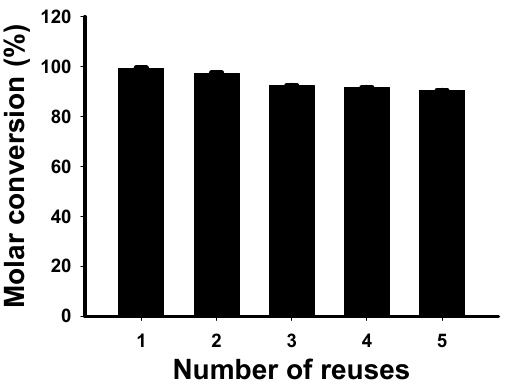
Figure 6. Reusability of Novozym ® 435 in the synthesis of 2-ethylhexyl ferulate performed under optimum conditions.